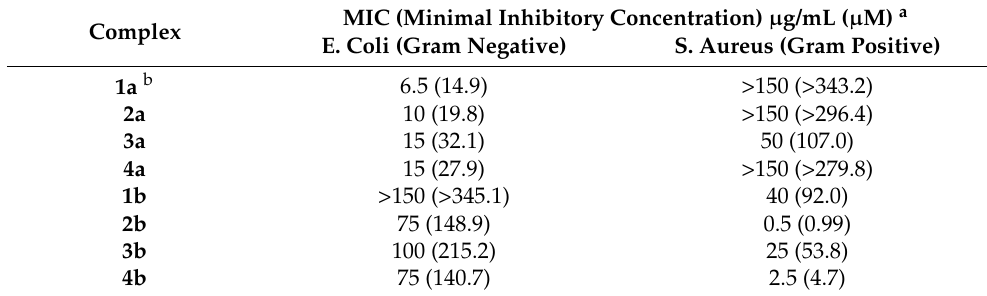
Table 2. Antimicrobial activity tested on representative Gram negative and positive bacteria.